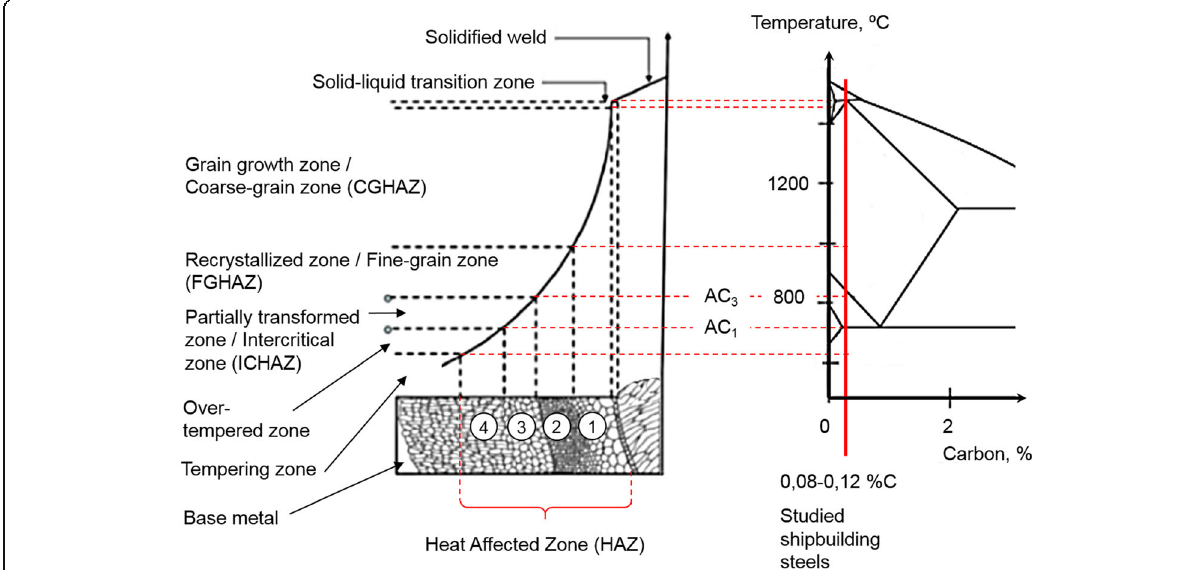
Fig. 1 Heat-affected zone structure and corresponding iron-carbon phase diagram (Grong 1997)